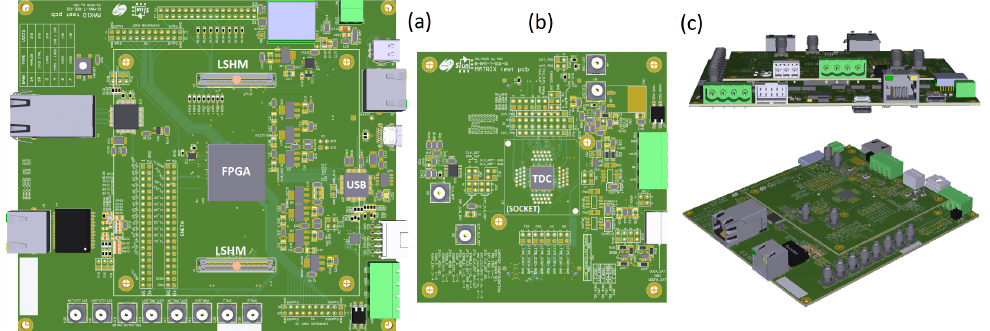
Figure 9. MATRIX16 test PCBs. ( a ) Motherboard hosting the MAX 10 FPGA, power regulators, and connectors. ( b ) Mezzanine board with the QFN64 footprint and socket. ( c ) Boards coupled